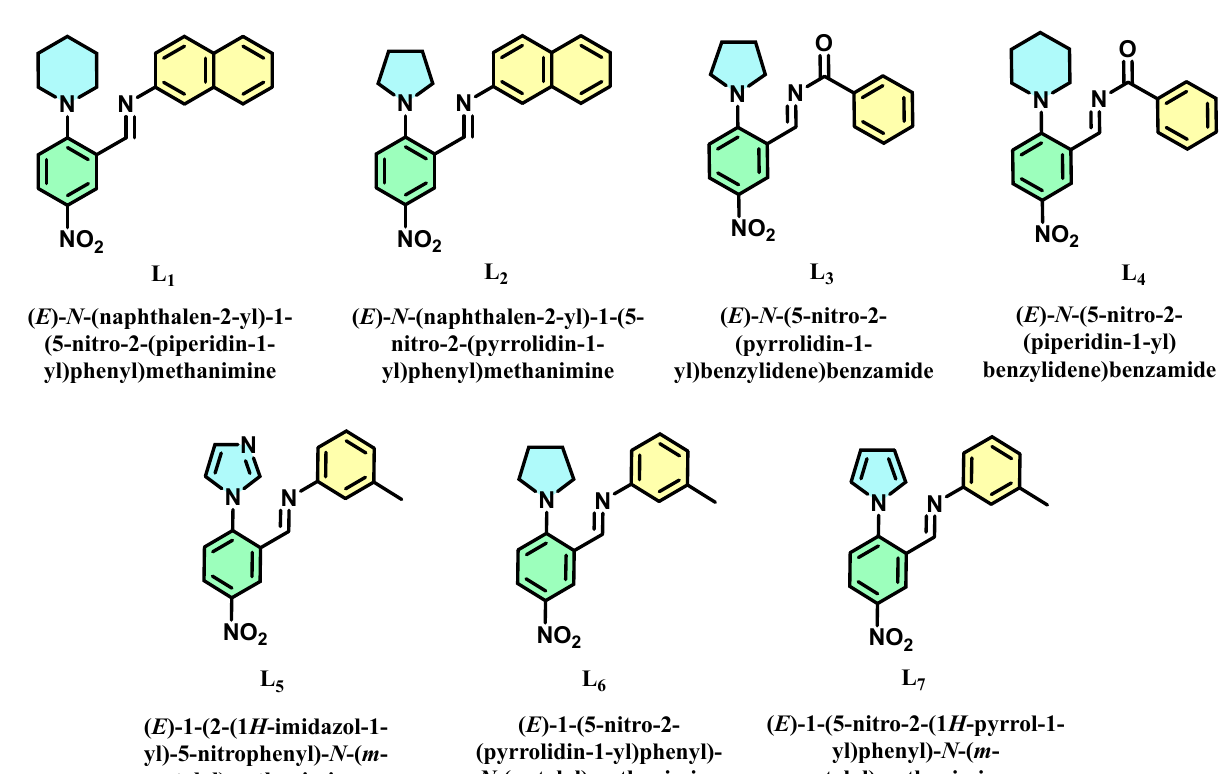
Figure 1. Molecular structures of seven dual inhibitors (L 1–7 ).